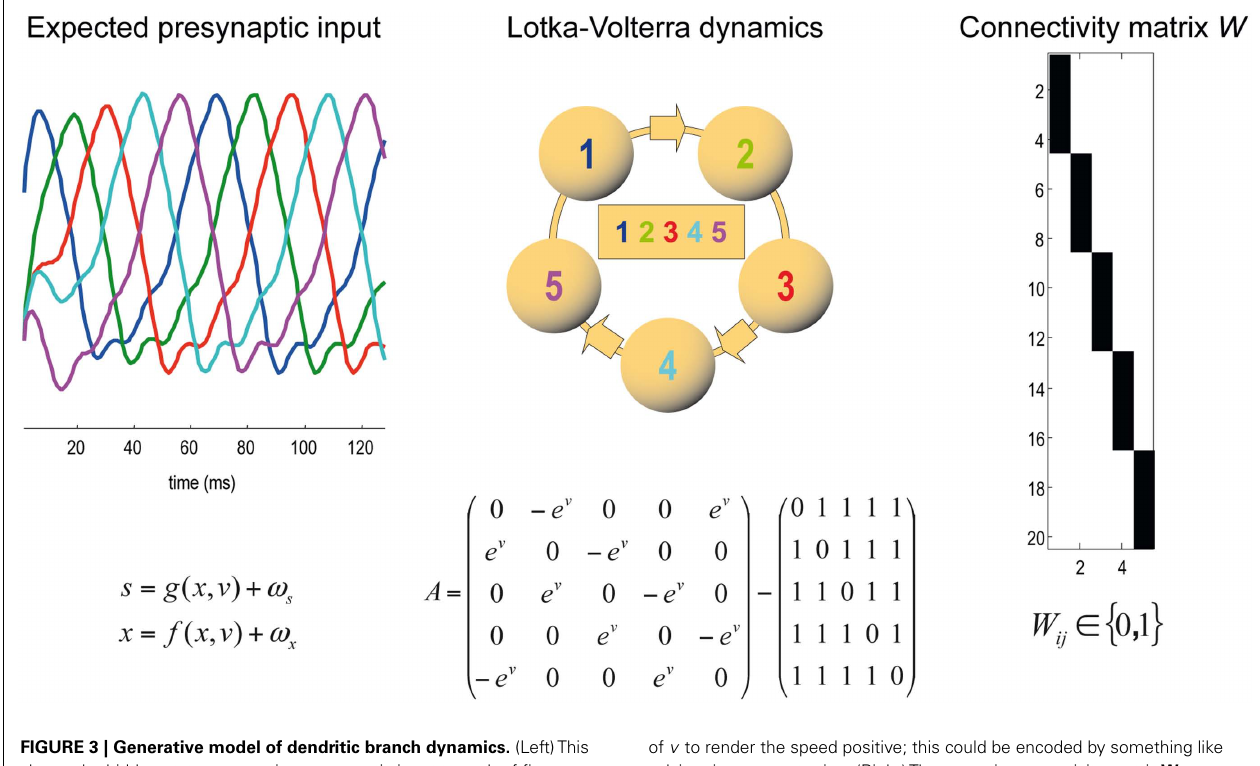
FIGURE 3 | Generative model of dendritic branch dynamics. (Left)This shows the hidden states generating presynaptic input to each of five segments.These Lotka–Volterra (winnerless competition) dynamics are generated by Eq. 1 in the main text.The inhibitory connectivity matrix A depends on the state v which determines the speed of the sequence. (Middle)The Lotka–Volterra dynamics are induced by the specific inhibitory connections among the five segments. In matrix A , we use the exponential